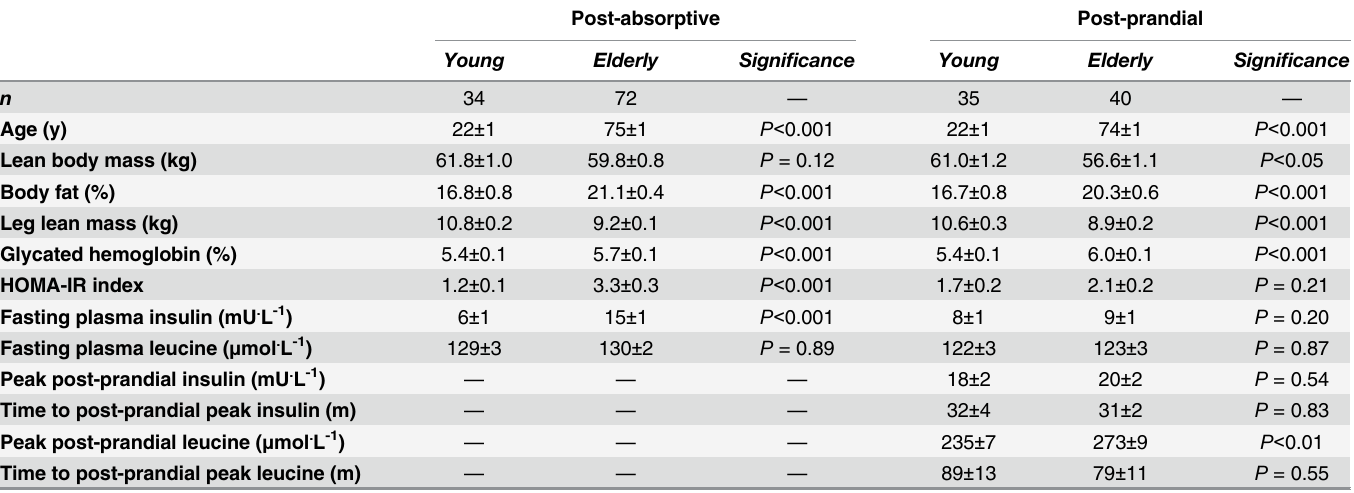
Table 1. Subjects ’ characteristics for comparisons of muscle protein synthesis